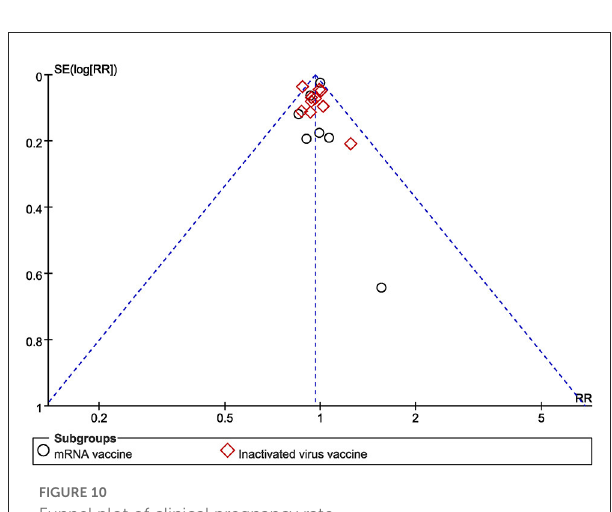
FIGURE10 Funnel plot of clinical pregnancy